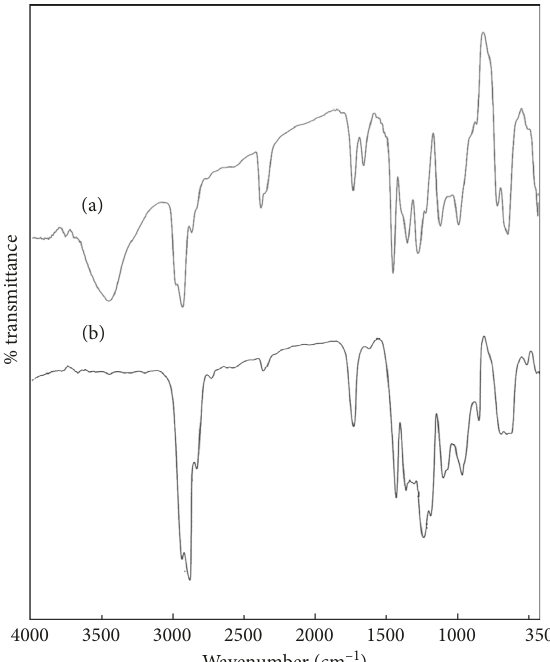
Figure 3: FTIR spectra of PVC modified by N -(4-BrPh)IM (a) before thermal degradation and (b) after thermal degradation, at 180 ° C, in